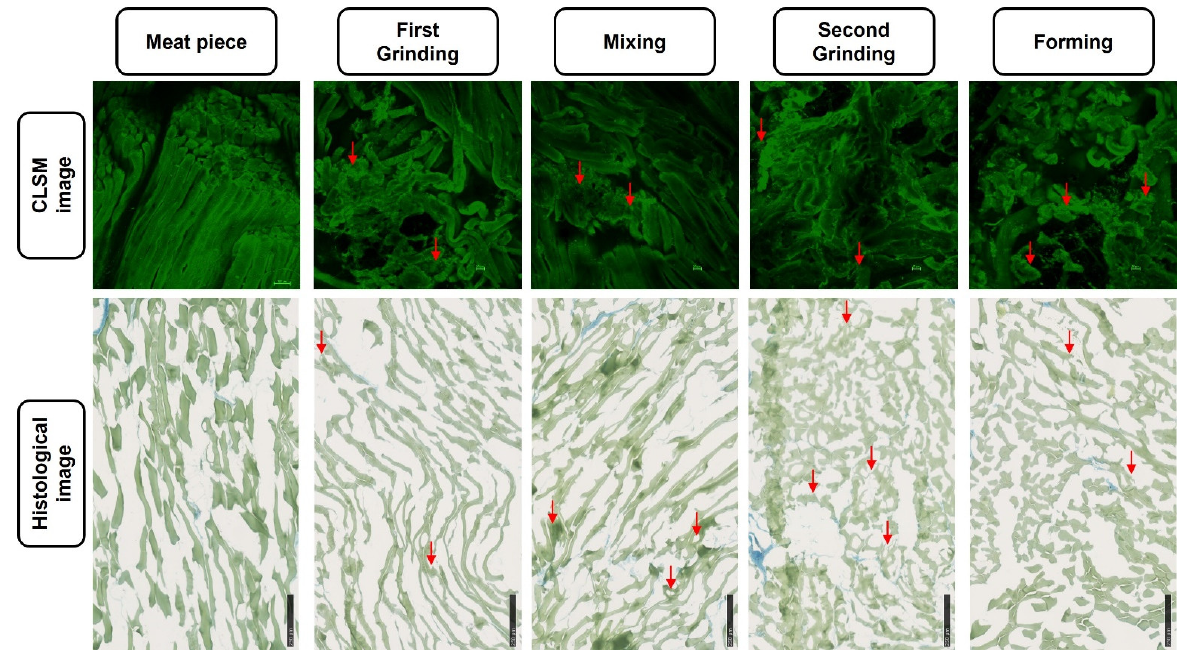
Figure 3. Confocal laser scanning microscopy ( CLSM ) and histological images of the meat samples at different processing stages. Red arrows exemplarily indicate non-intact cells; images from the same processing step do not represent the identical samples section.